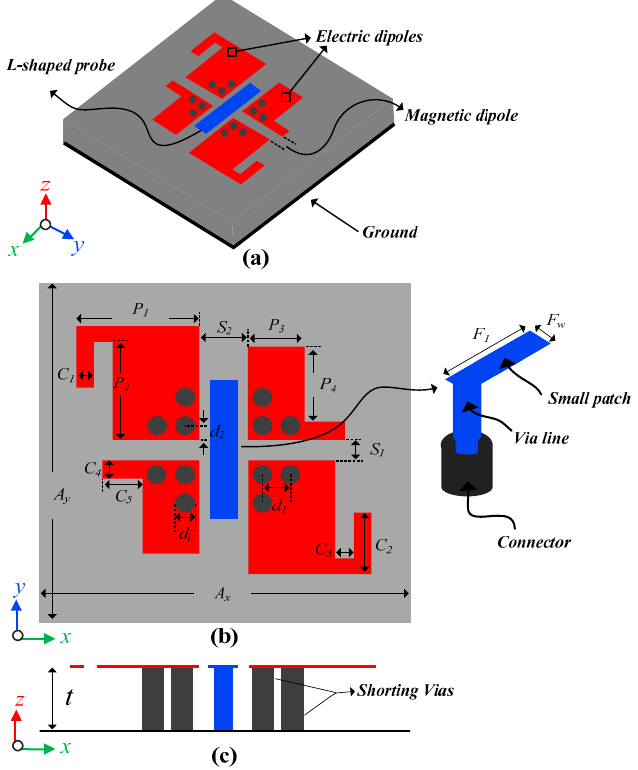
Figure 2. The geometry of the proposed CP ME antenna: ( a ) 3D view, ( b ) top view, and ( c ) side view. Table 1. Optimized dimensions of the proposed CP ME dipole antenna.